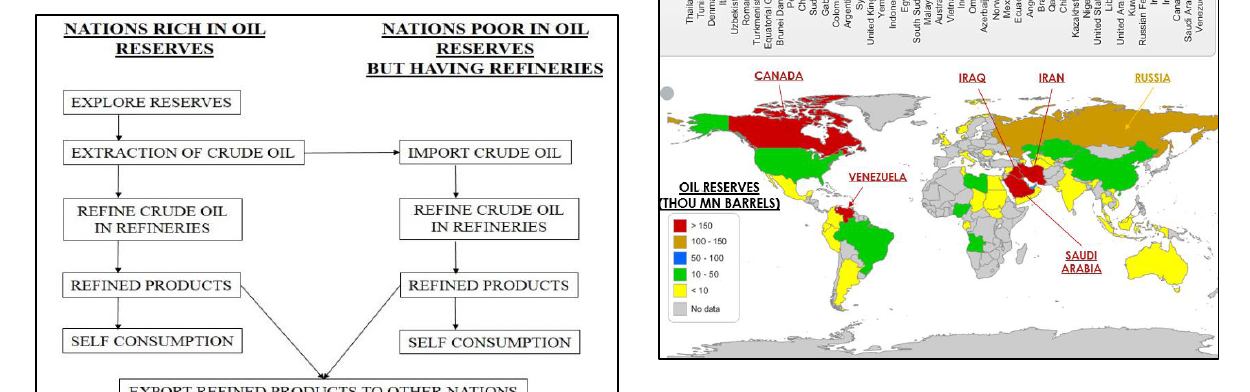
Figure 4. Statistics of proved oil reserves in